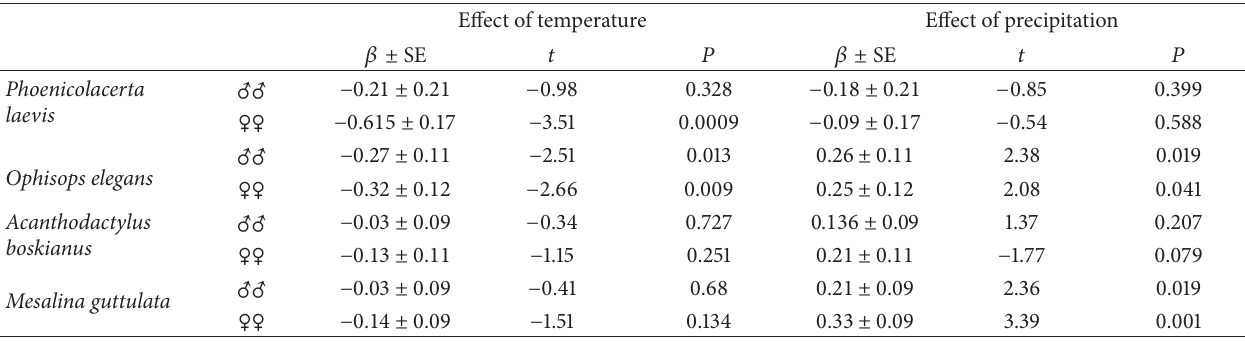
Table 4: The effect of climate variables on snout-vent length (SVL). Results of multiple regression with SVL as a dependent variable and climatic factors as